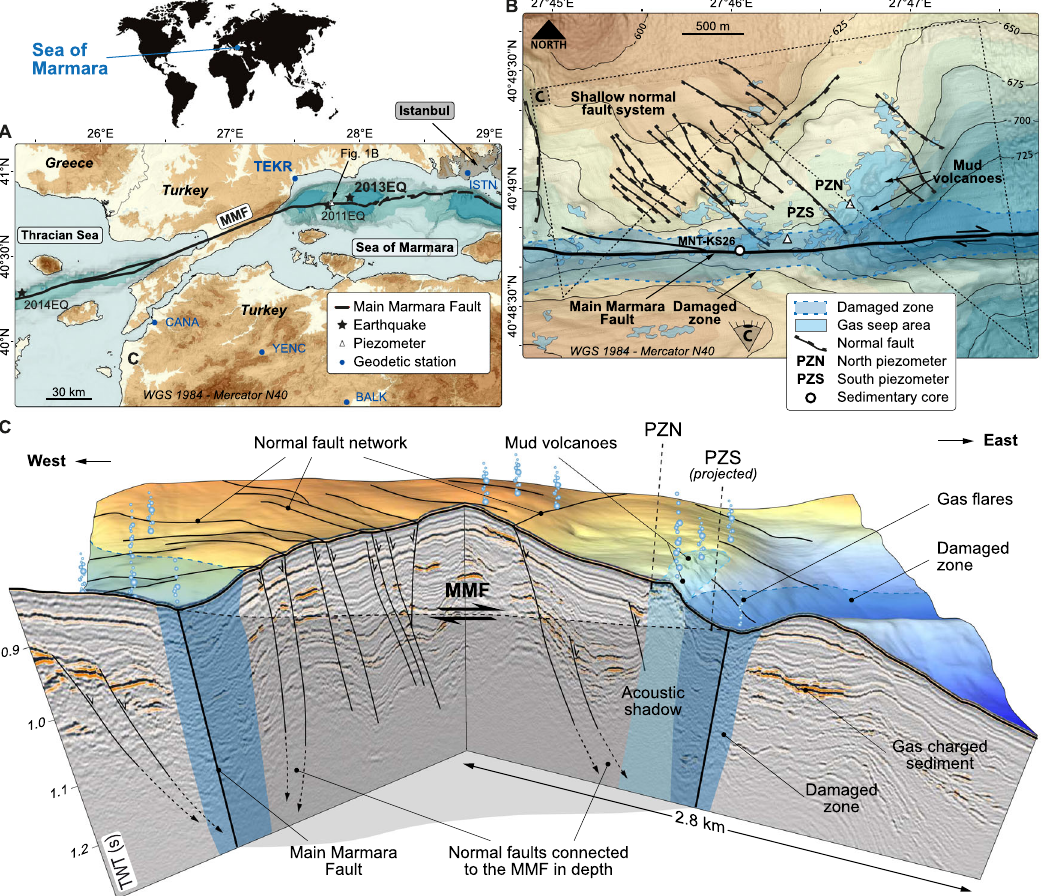
Fig. 1 Study area. A General map showing the study area, the onshore GPS stations (dots indicating from west to east: CANA, YENC, TEKR, BALK, and ISTN stations), and the 2011EQ, 2013EQ, and 2014EQ earthquake epicenters (black stars). The thick black line 11 indicates the trace of the northern strand of the North-Anatolian Fault. Background map boundaries are provided by ArcGIS Data and Maps. Redistribution rights are granted. https://www.esri.com/ content/dam/esrisites/en-us/media/legal/redistribution-rights/redist-rights-2021.pdf. B Zoom of bathymetry showing piezometers PZN and PZS and their positions with respect to the Main Marmara Fault (MMF) and its damaged zone (Supplementary Fig. 1), the mud volcanoes (MVs), and gas seep areas 17 . C 3D diagram including interpreted seismic lines extracted from 3D HR seismic data and indicating the position of PZN and